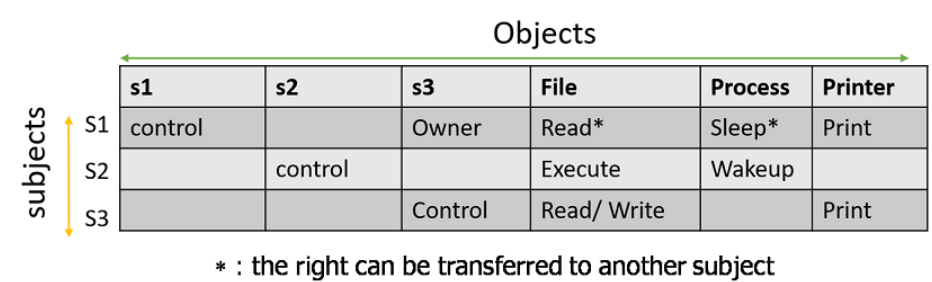
Figure 3. Example of an access control